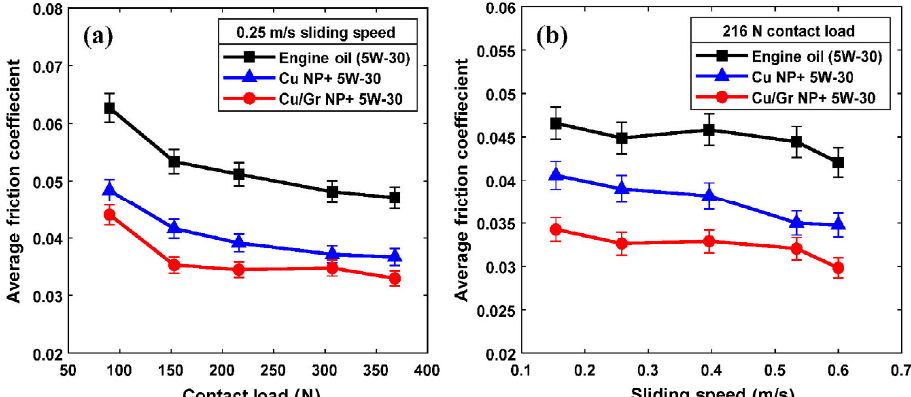
Fig. 6 COF behavior for both the nano-additives and reference oil with respect to different contact loads and sliding speeds. The error bars indicate the standard deviations.